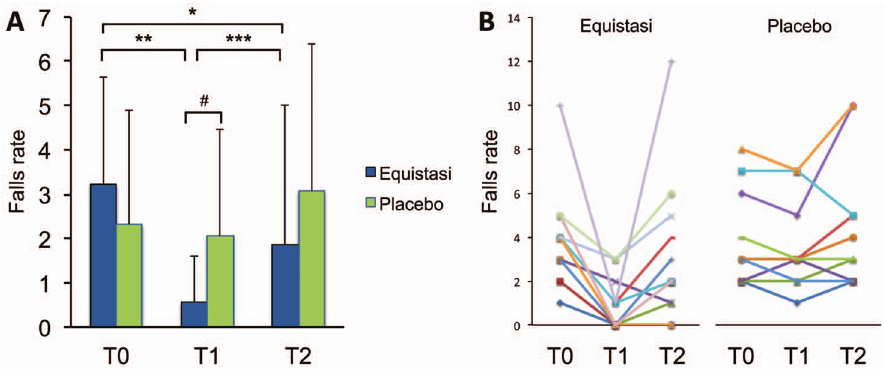
Figure 4. The Falls rate over the 2-month observation period. Data are presented as mean 6 standard deviation (A) and individual trends excluding patients with no baseline history of falls (B). Abbreviations: *: p=.03; **: p=.0001; ***: p=.003 (Wilcoxon signed-rank test); # : p=.03 (Mann-Whitney U test).